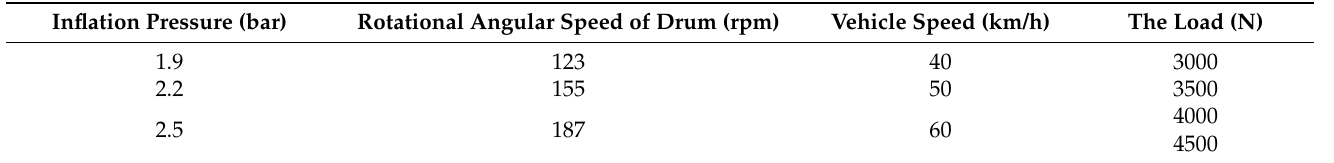
Table 2. Different operational conditions of the tire and drum.